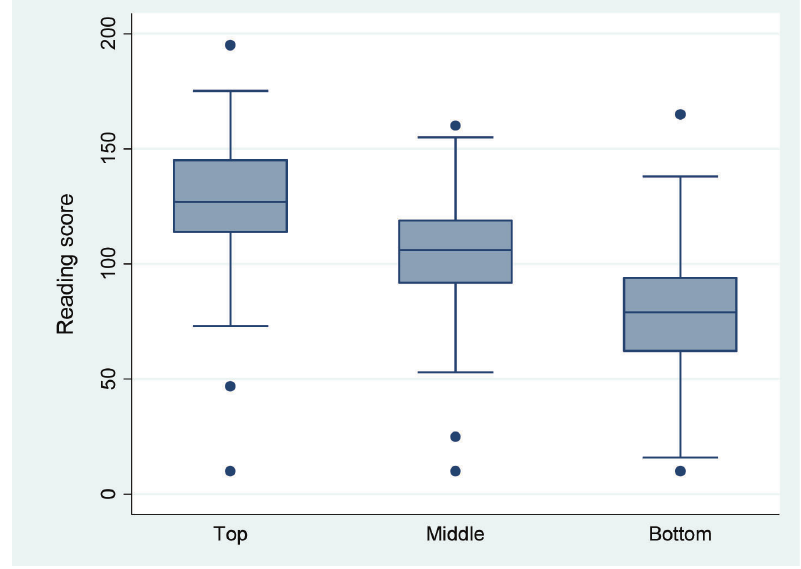
Figure 2: Distribution of Word Reading scores: sample pupils across streams n = 837; Mean for all pupils = 108.5. Line represents median, box represents 25th and 75th percentiles (Q1 and Q3, respectively), whiskers represent Q3+1.5(Q3–Q1) /